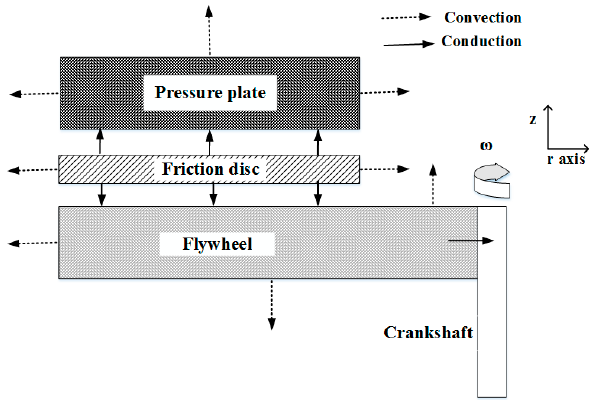
Figure 3. Schematic representation of thermal energy flow in the studied clutch system assembly.